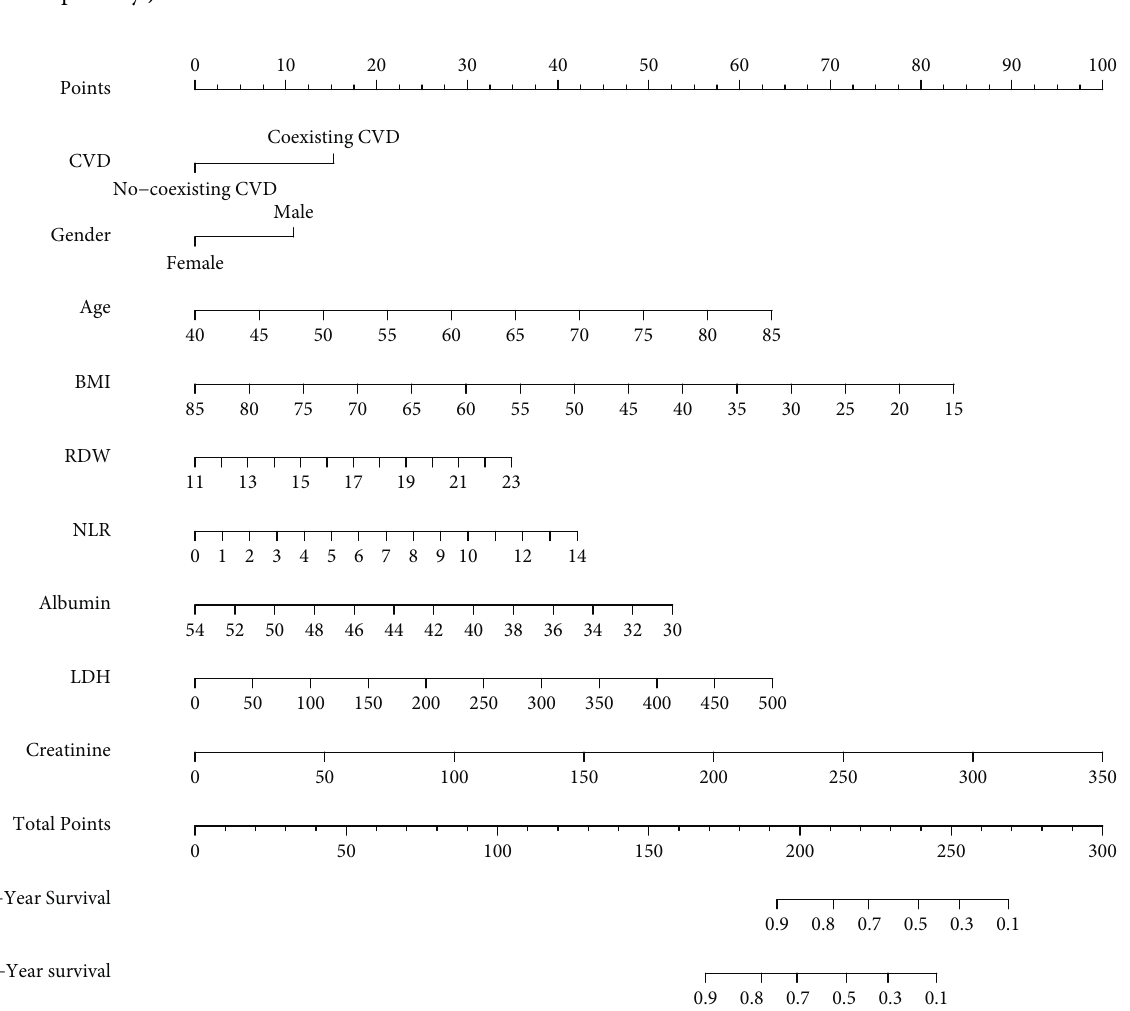
Figure 4: Nomogram showing results of the prognostic model using CVD, gender, age, BMI, RDW, NLR, albumin, LDH, and creatinine for prediction of 5-year, and 10-year survival of COPD. Each prognostic factor corresponded to a score, and the total score of an individual patient was obtained by adding the scores of the individual factors, and a straight line was drawn on the axis of the total score to predict the 5- and 10-year survival of